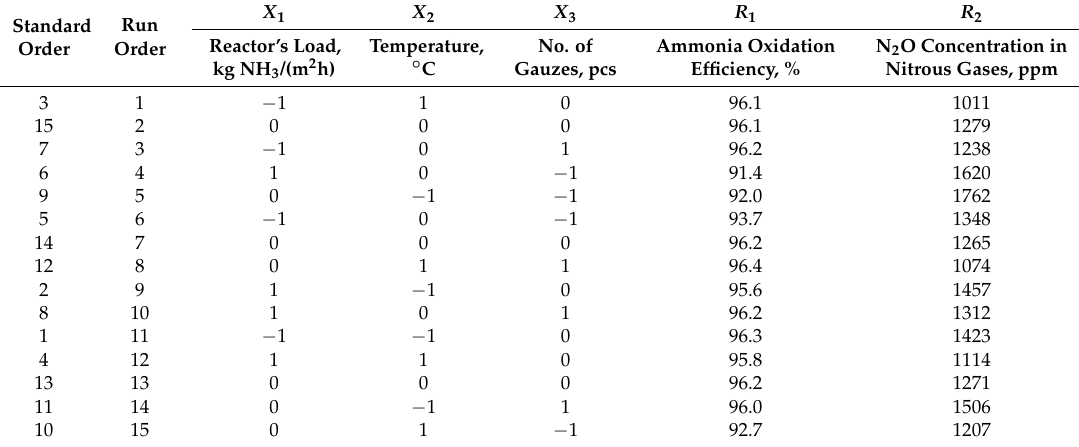
Table 1. The Box-Behnken design matrix and experimental data.